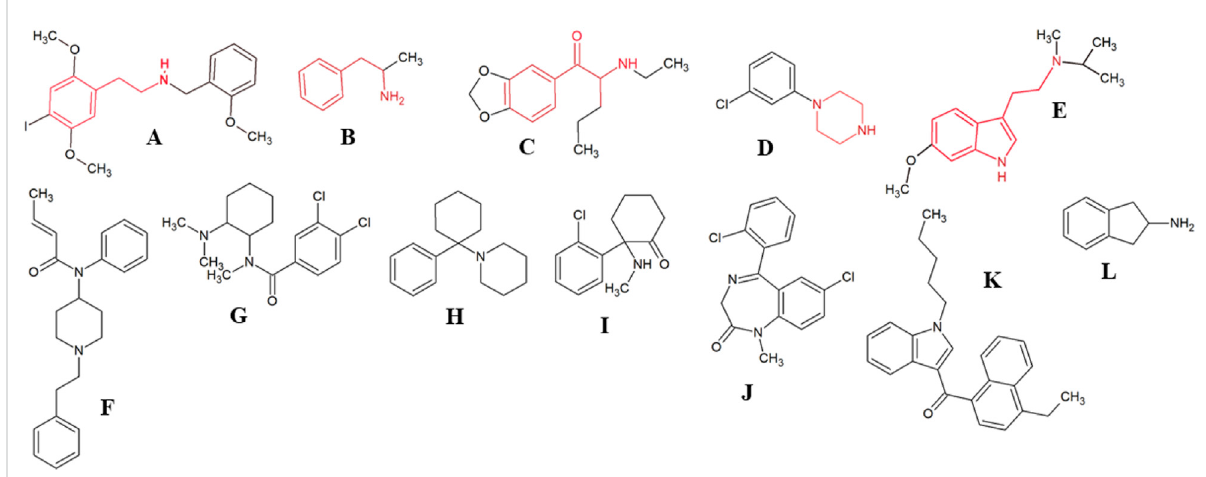
FIGURE 1 ChemicalstructureofthemaincompoundsfromtheNPSclassesdiscussedinthispaper.25I-NBOMe (A) andamphetamine (B) ,highlightingthe phenethylamine core (red); the synthetic cathinone N-ethylpentylone (C) , highlighting the cathinone core (red); m-CPP (D) , highlighting the piperazine core (red); 5-MeO-MIPT (E) , highlighting the tryptamine core (red); Opioids: fentanyl analog crotonylfentanyl (F) and U-47700 (G) ; phencyclidine (H) and the analogue ketamine (I) ; designer benzodiazepine diclazepam (J) ; synthetic cannabinoid JWH-210 (K) ; 2- Aminoindane (L)